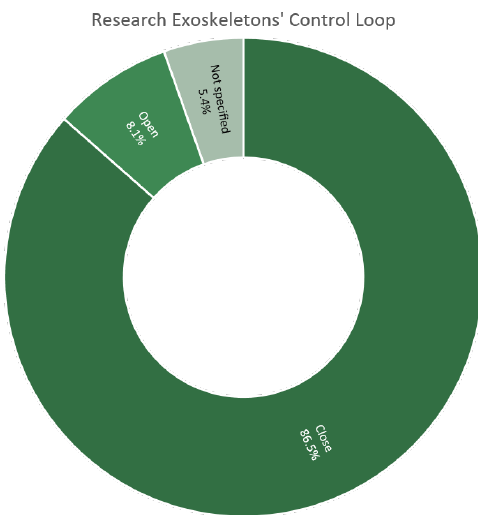
Figure 11. This chart portrays the control loop of the exoskeletons in the research